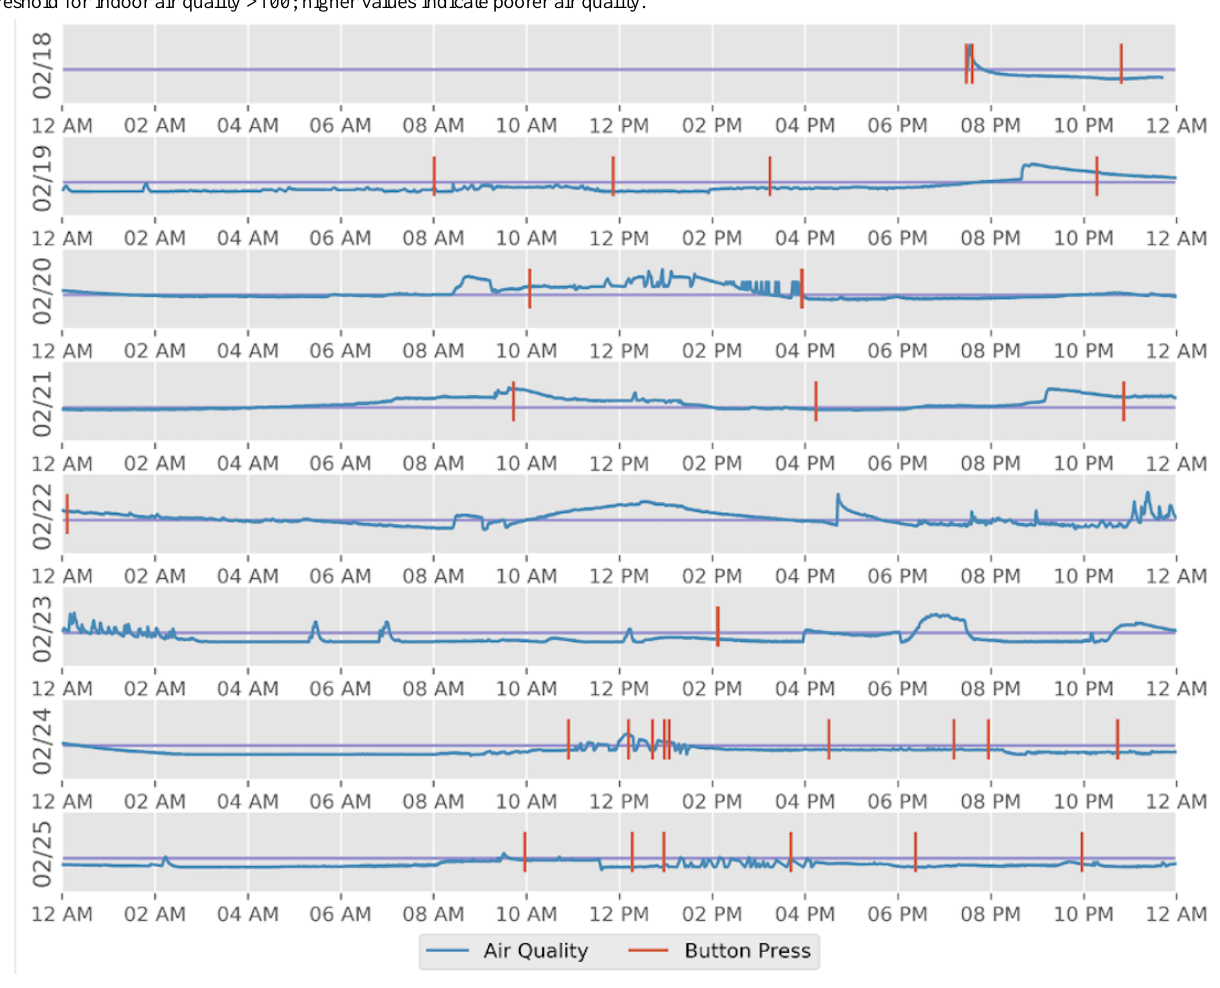
Figure 2. SR's experimental data. The red lines indicate a button press, the blue line indicates indoor air quality, and the purple line indicates the threshold for indoor air quality >100; higher values indicate poorer air